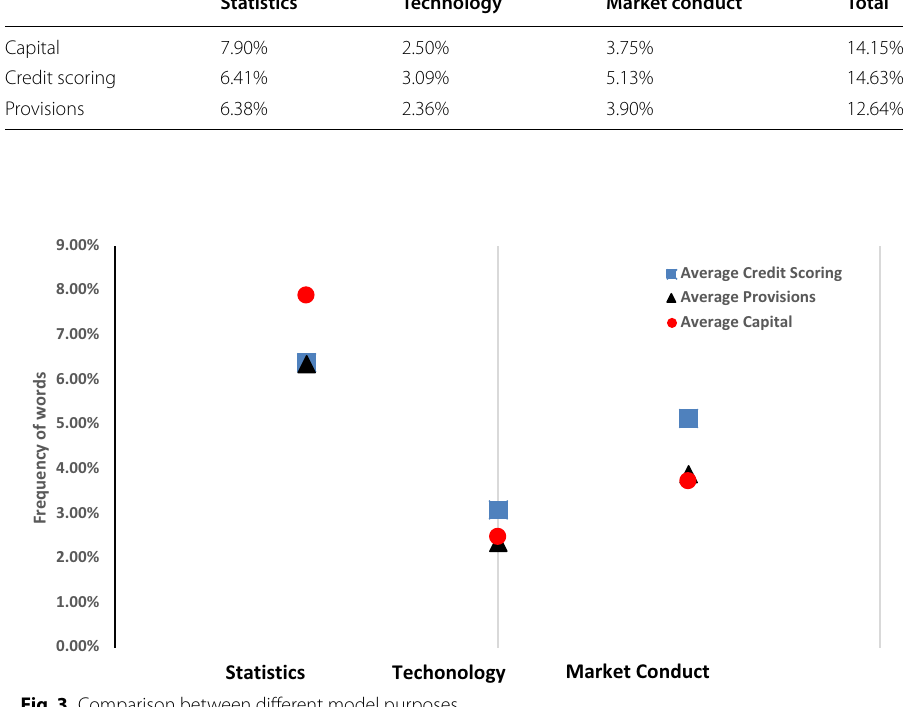
Table 2 Overall relative frequency of categories in model uses Statistics